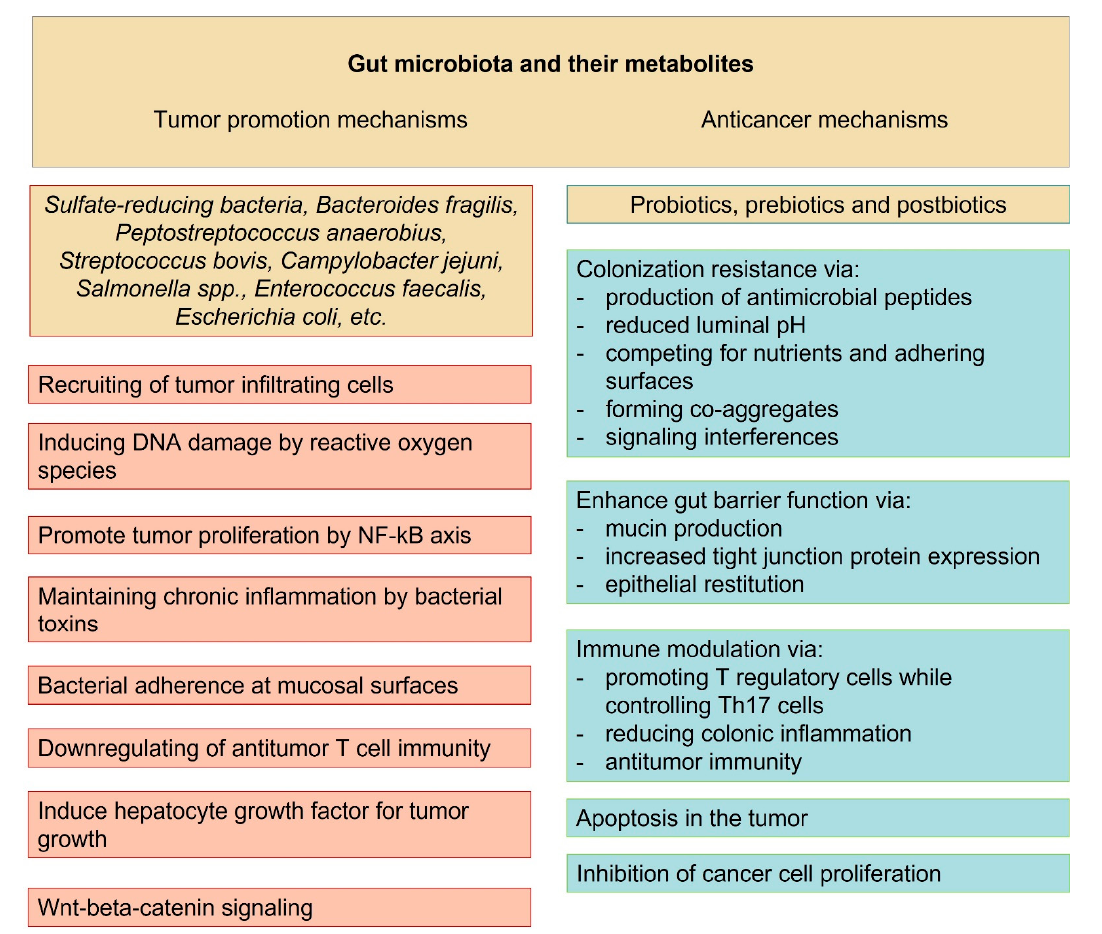
Figure 2. Tumor promoting and anticancer mechanisms and pathways of gut microbiota and their metabolites.